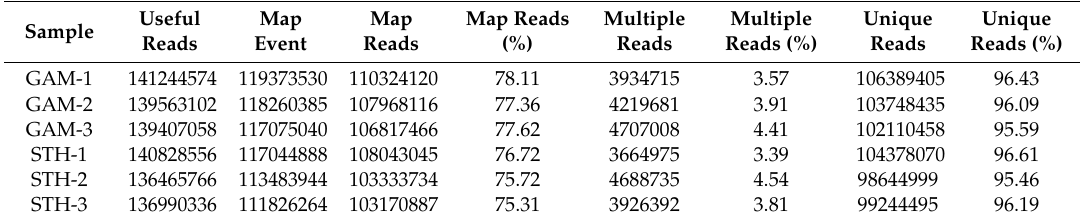
Table 2. Summary of the RNA-Seq analyses after mapping to the reference